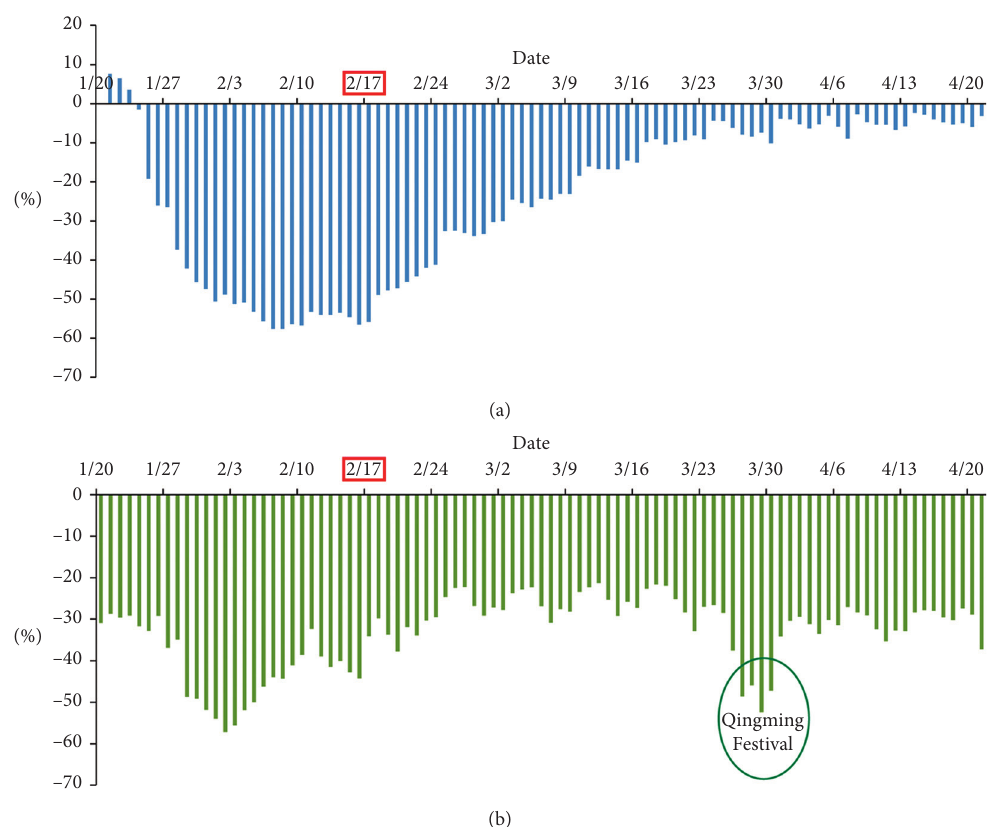
Figure 2: Daily variation in the average mobility-within-city index and mobility-between-cities index during the epidemic of COVID-19 in China, January 20 to April 21, 2020. (a) Mobility-within-city index (MWCI). (b) Mobility-between-cities index